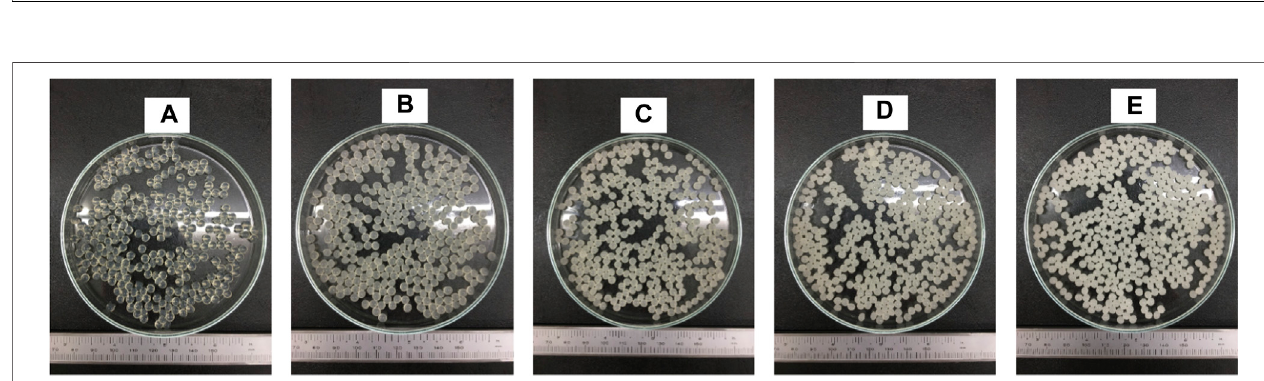
FIGURE5| Digitalphotoofpectin/hi-maizestarchhydrogelbeadswithdifferentpectin:hi-maizestarchratios: (A) beadP1(6:0), (B) beadP2(5.5:0.5), (C) beadP3 (5: 1), (D) bead P4 (4.5: 1.5), and (E) bead P5 (4: 2).